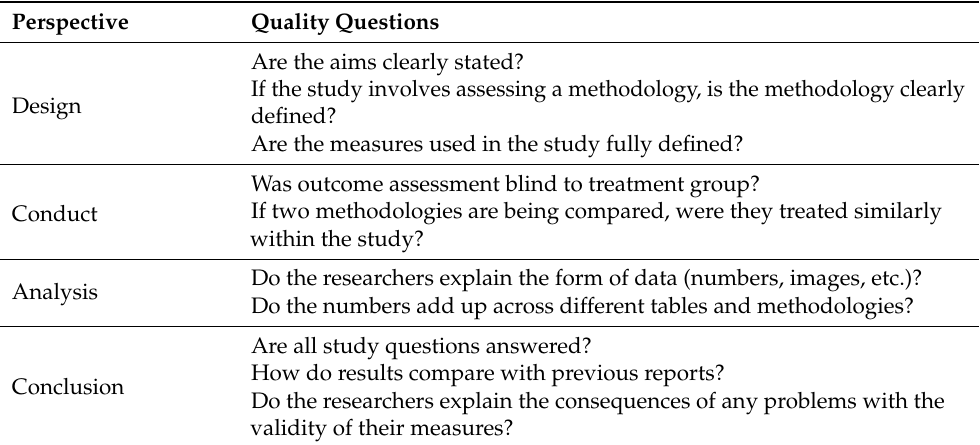
Table 2. Questions for checking the validity of the selected